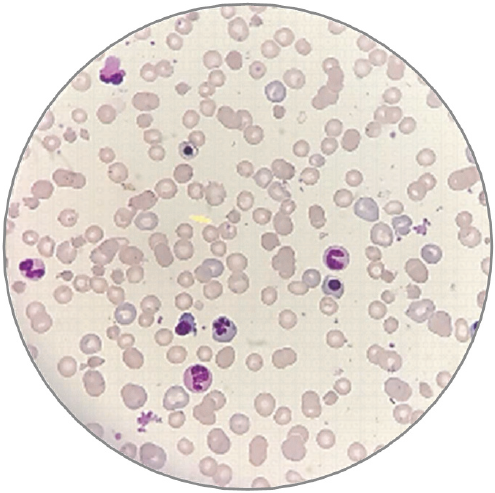
Figure 1: Peripheral blood smear showing polychromatophilia, numerous microspherocytes, and erythroblasts, some of which are dysplastic; schizocytes, Heinz bodies, and “bite cells” were not seen (Giemsa